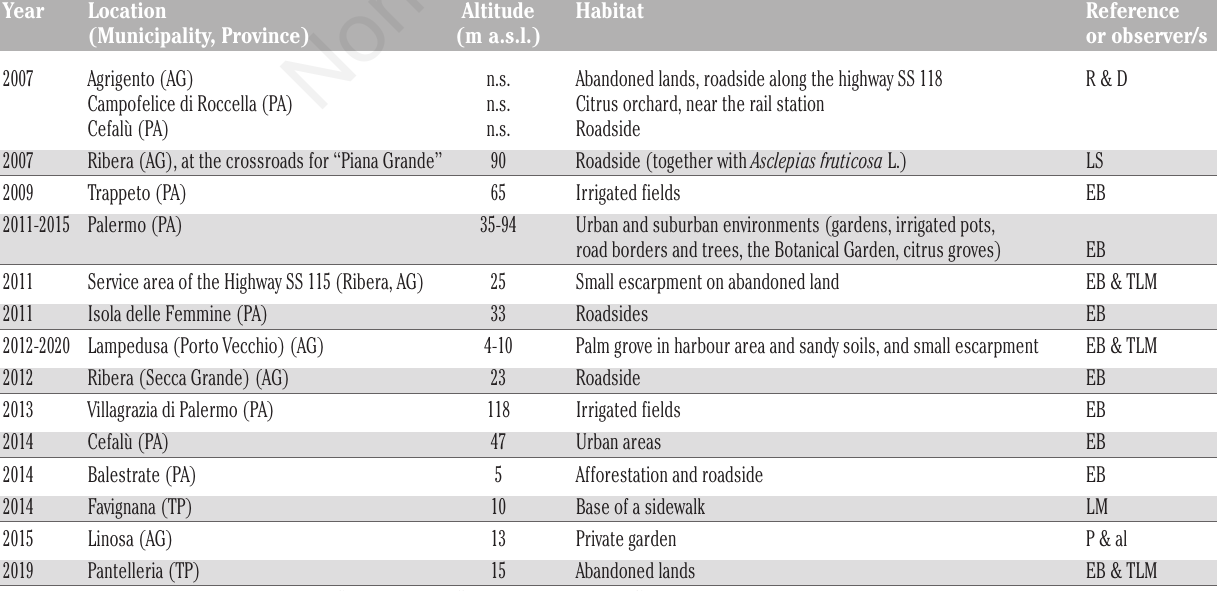
Figure 1. Massive natural regeneration of Leucaena underneath a mature individual cul- tivated in a coastal area (Trappeto, province of Palermo) (photo by E. Table 1. Historical and new records of naturalization events by Leucaena leucocephala subsp. glabrata in Sicily.